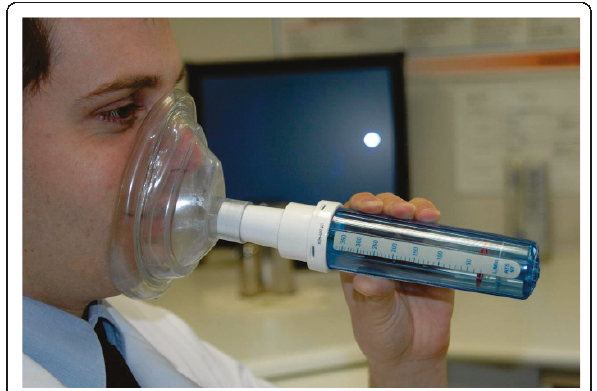
Figure 12 Peak nasal inspiratory flow measurement .